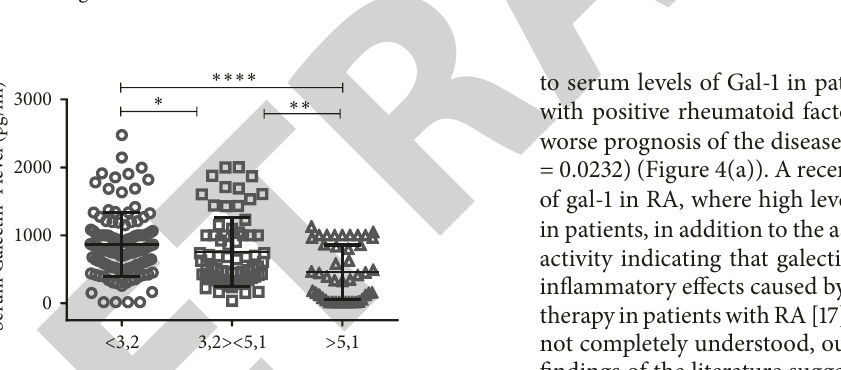
Figure 3: Evaluation of the Disease Activity Score for 28 joints (DAS28) with serum levels of